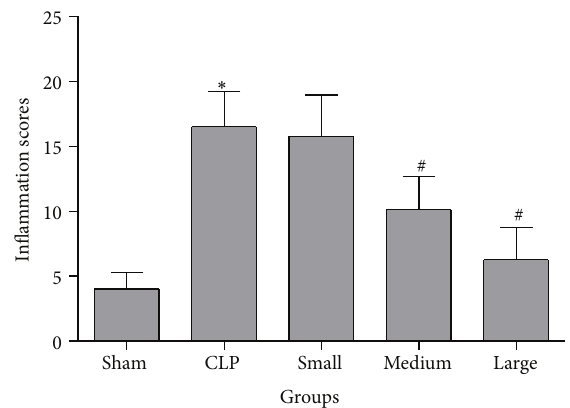
Figure 3: Pulmonary inflammation scores of rats from different groups. Sham: sham operation group; CLP: cecal ligation and punc- ture operation group; Small: 5 𝜇 g/kg dexmedetomidine treatment group;Medium:10 𝜇 g/kgdexmedetomidinetreatmentgroup;Large: 20 𝜇 g/kg dexmedetomidine treatment group. Data are expressed as mean ± SD, 𝑛 = 8 . ∗ 𝑃 < 0.01 , versus sham group; # 𝑃 < 0.01 , versus CLP